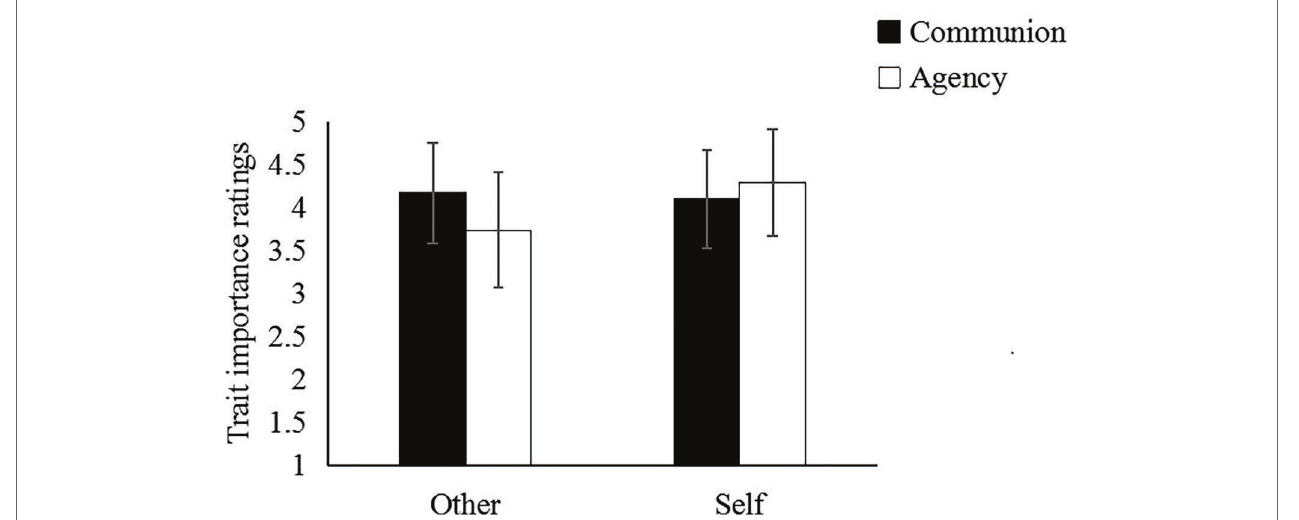
FIGURE 1 | Importance of communal and agentic traits for the self versus for another